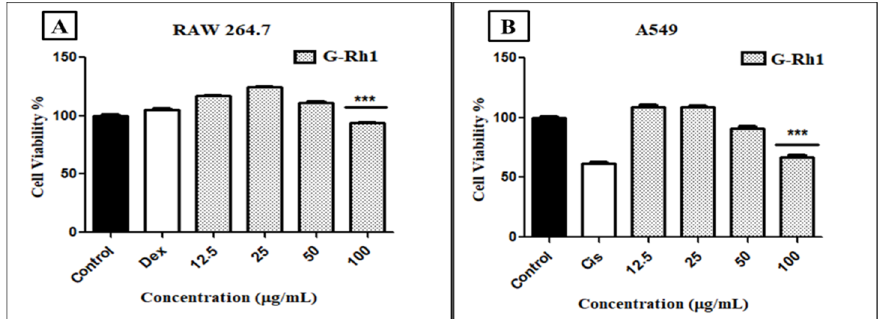
Figure 9 . In vitro, cell cytotoxicity evaluation for ginsenosides Rh1 ( A ) on murine macrophage (RAW 264.7), ( B ) on human lg carcinoma (A549) cells compared to positive control (cisplatin). Graph shows mean ± SD values of four replicates. *** p < 0.001 indicates significant differences from control groups.